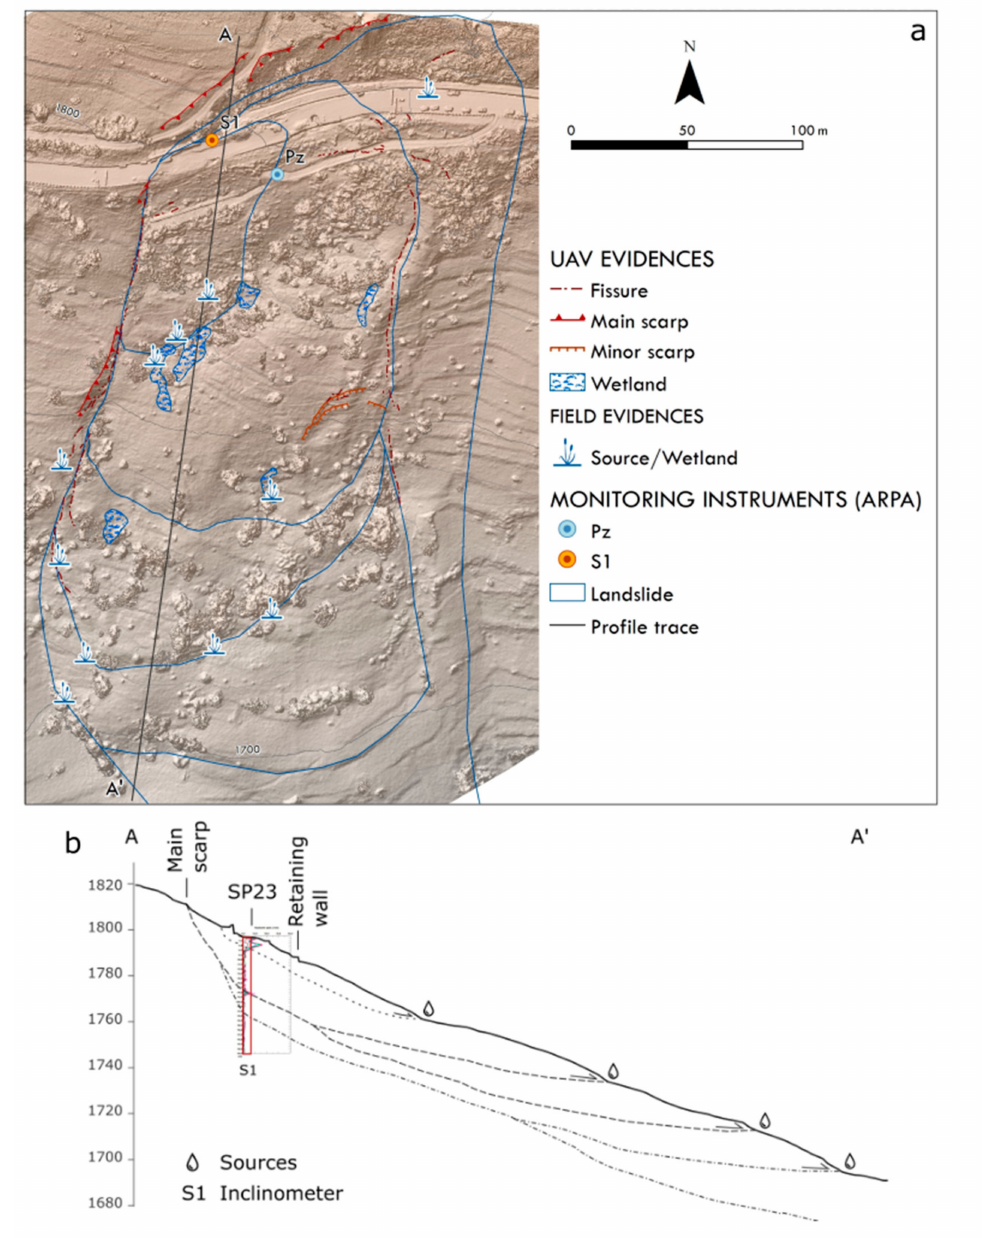
Figure 14. ( a ) Map of the Champlas du Col observed landslides associated with the main morphological features due to the spring 2018 reactivation, and ( b ) longitudinal profile associated with the resulting displacement graph calculated during June–November